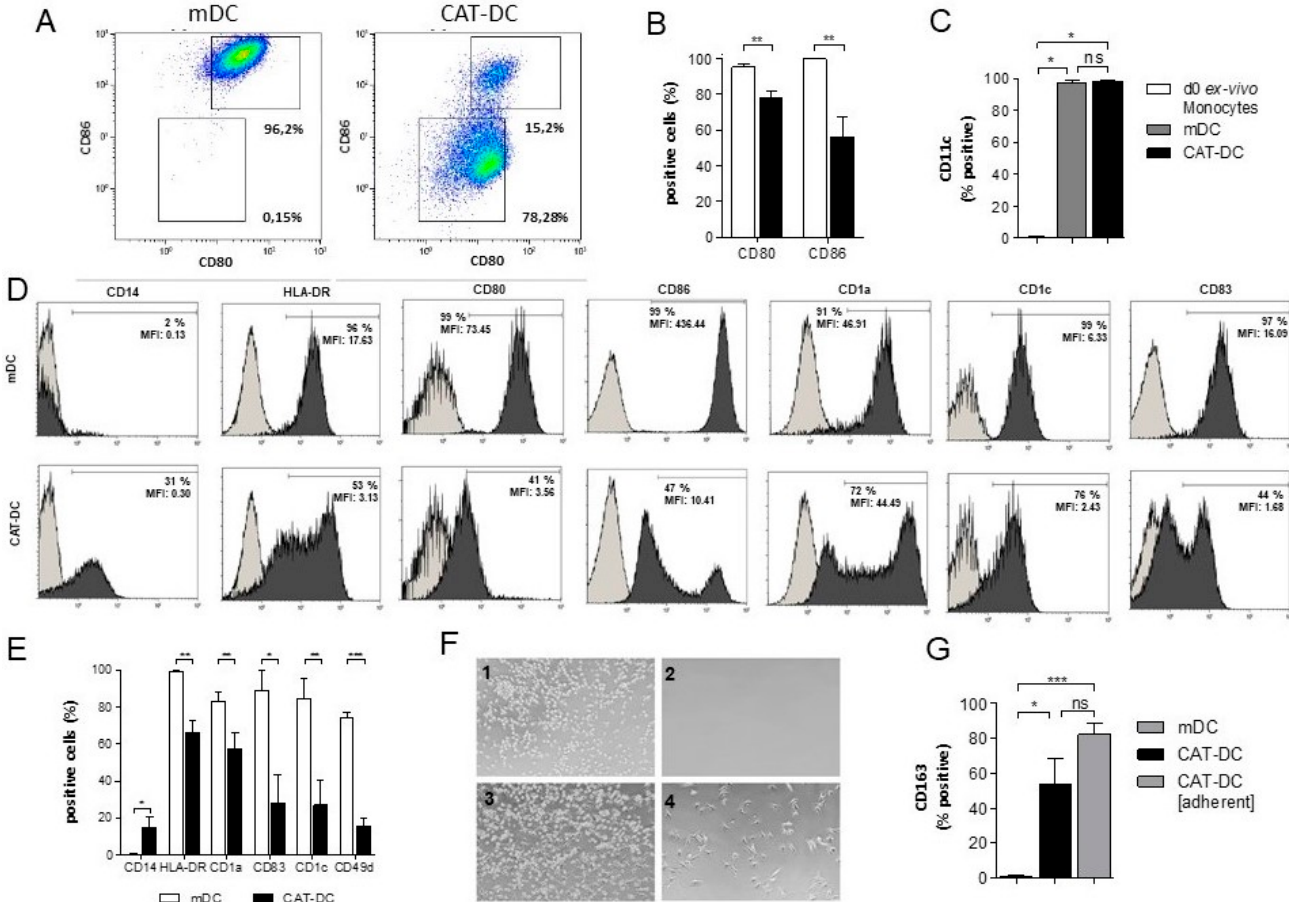
Figure 1. Differentiation and maturation of human moDCs in the presence of catalase leads to an immature phenotype. Analysis of surface marker expression by flow cytometry. Monocytes differentiated and matured in the presence of IL4, GM-CSF and LPS were defined as mDCs and characterized as CD80 + /CD86 + . moDCs additionally treated with purified catalase during differentiation and maturation where defined as CAT-DCs. ( A , B ) Flow-cytometric analysis of CD80 and CD86 expression of CAT-DCs compared to mDCs (A: representative plots; B: mean % values from n = 6 experiments with SD values). ( C ) Flow-cytometric analysis of CD11c on ex-vivo monocytes, mDCS and CAT-DCs. ( D ) Exemplary histograms of cell surface markers expressed on mDCs and CAT-DCs after 7 days of culture as analyzed by flow cytometry. Gray plots: isotype controls; MFIs represents the MFIs of all cells analyzed by flow cytometry for the according surface marker (raw data can be found in Figure S3). ( E ) Flow-cytometric analysis of maturation-marker-expression on CAT-DCs as compared to mDCs. ( F ) Formation of an adherent, morphologically distinct subpopulation in DCs differentiated and matured in the presence of catalase; exemplary images shown for mDCs (1) and CAT-DCs (3) after 7 days of culture vs. mDCs (2) and CAT-DCs (4) culture dishes after gentle detachment by washing. ( G ) Comparison of CD163 expression of mDCs, non-adherent CAT-DCs, and adherent CAT-DCs ( n = 3). General gating strategy for flow-cytometric analysis of DC surface markers with dead cell exclusion using SYTOX blue dead cell stain and definition of mDCs as CD80 + /CD86 + and CAT-DCs as CD80 low/ − /CD86 − can be viewed in Figure S1. Statistical analysis was performed with a paired two-tail Student’s t -test. p -values indicated as * p < 0.05, ** p < 0.01, *** p <